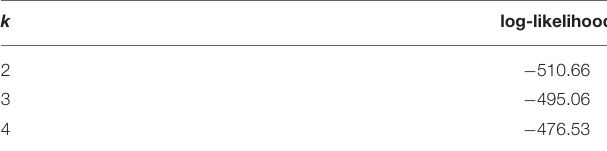
TABLE 2 | Comparison of the log-likelihoods of multivariate normal mixture models fitted with k